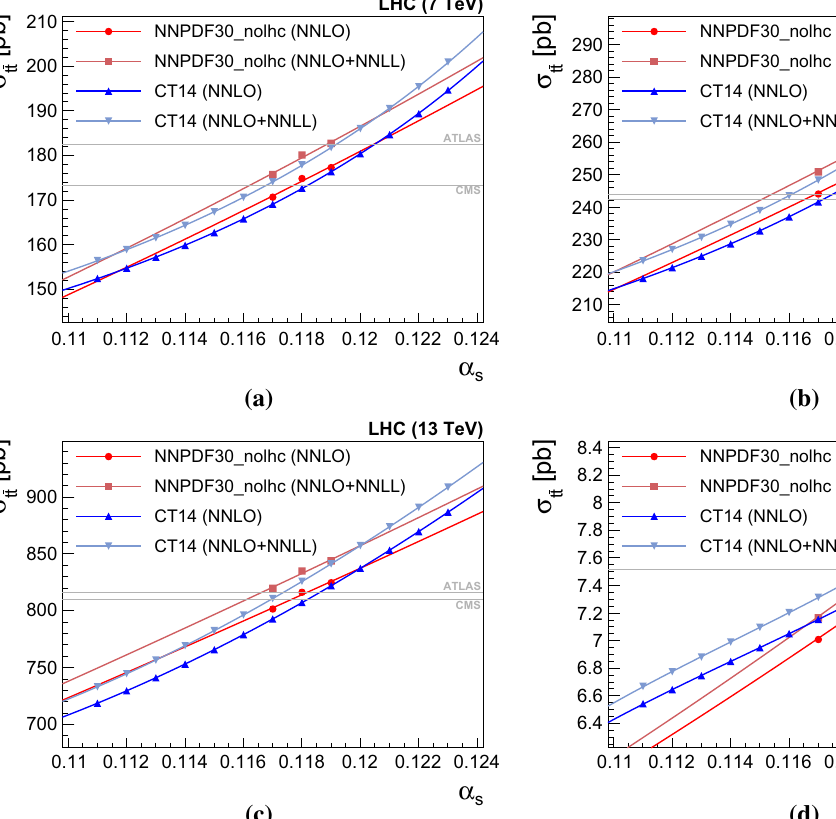
Fig. 1 Predicted cross section as a function of α s . The points are the cross sections calculated using the Top++ program [23], and the line is our polynomial fit. The plot also includes horizontal lines